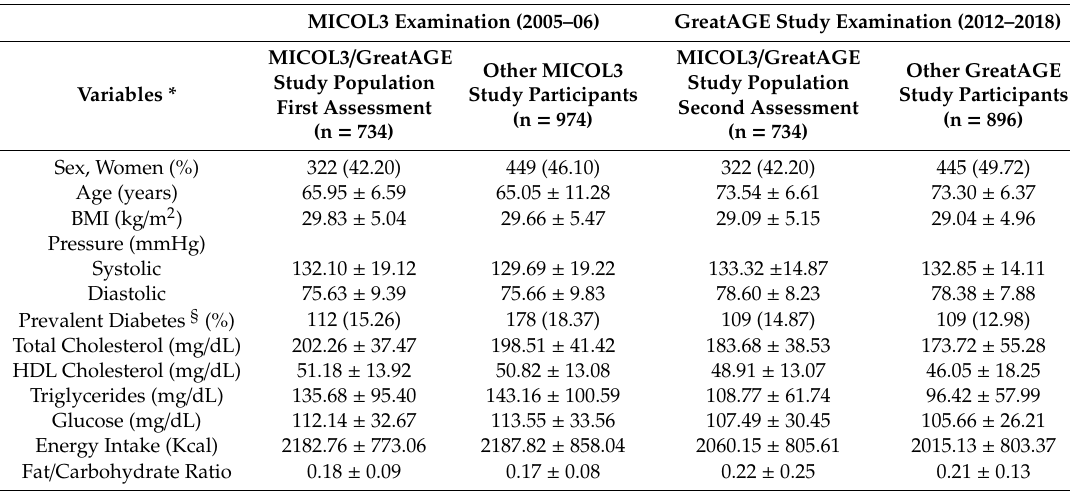
Table 2. Characteristics of the study